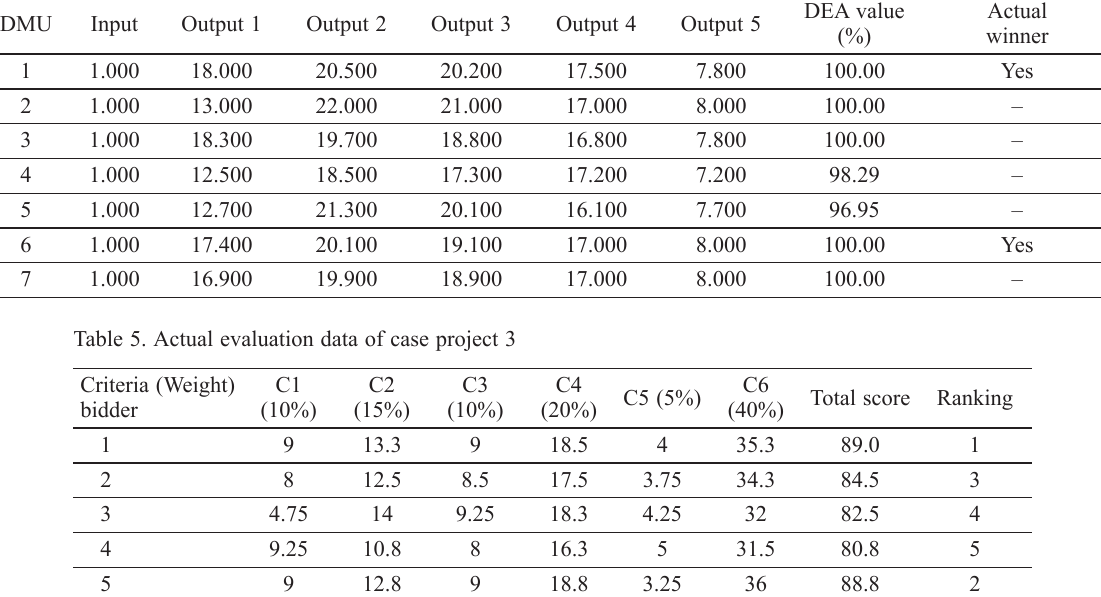
Table 4. DEA evaluation results of case project 2